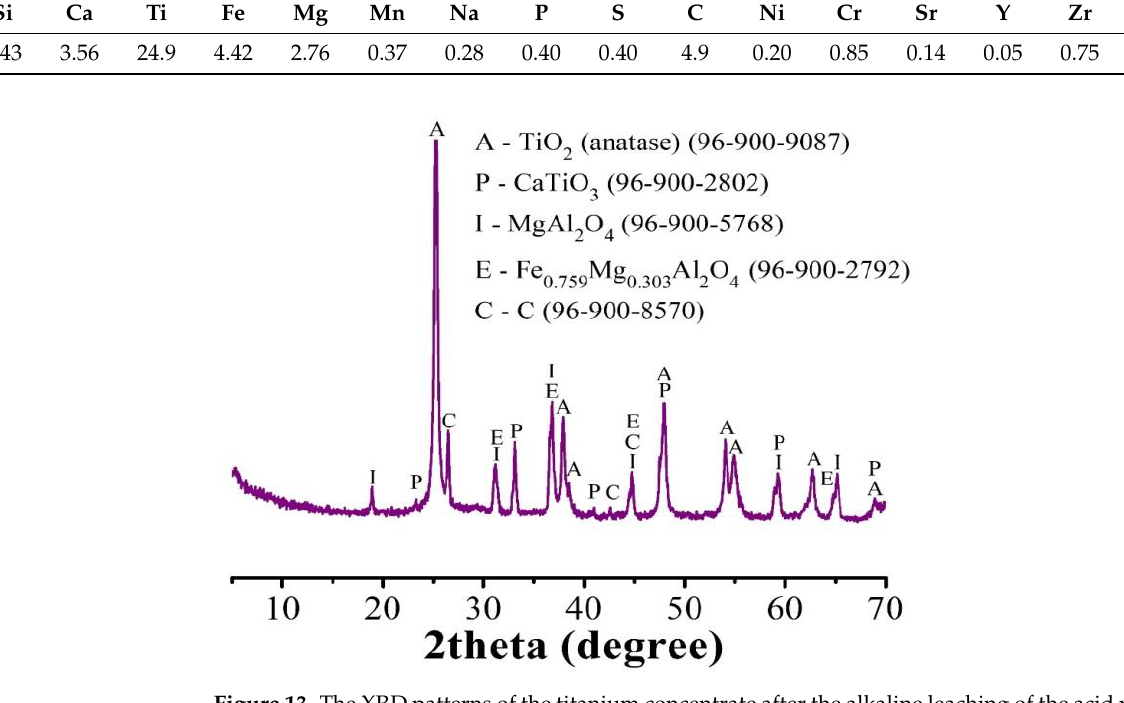
Figure 13. The XRD patterns of the titanium concentrate after the alkaline leaching of the acid resi- due.